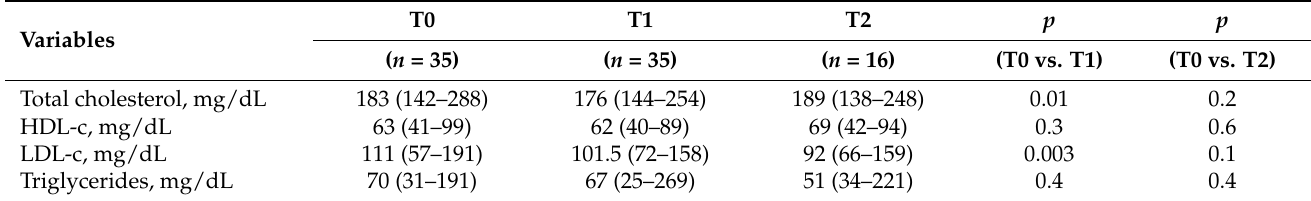
Table 7. Changes in lipid